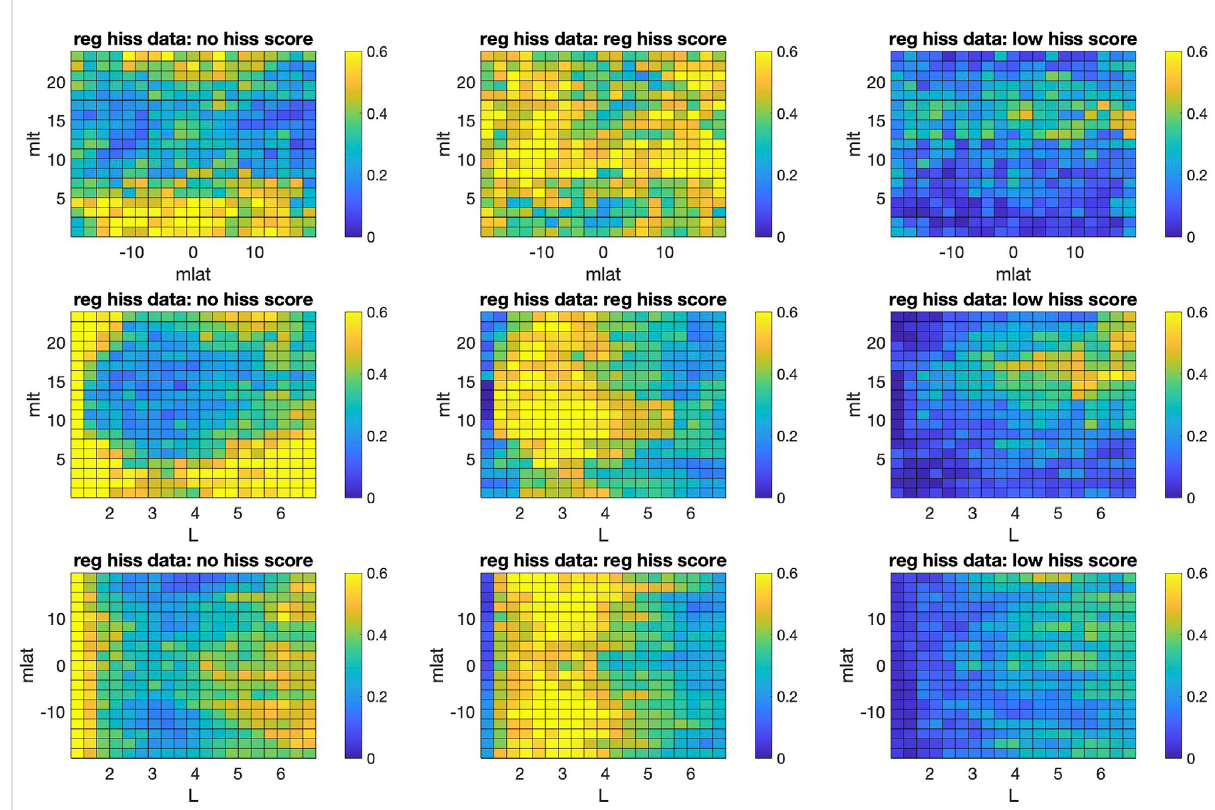
FIGURE 6 Partial dependence (Eq. 2) computed on “ regular hiss ” data points; color bar corresponds to the score of RF